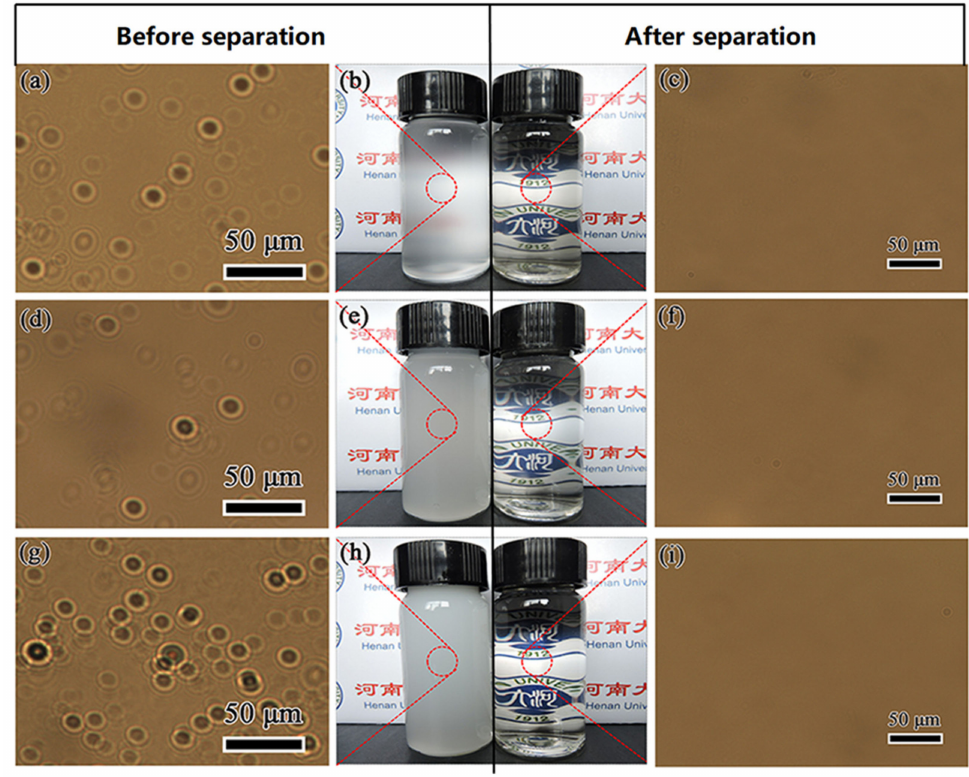
Figure 8. Optical microscopes and digital camera photos of different oil-in-water emulsions: ( a – c ) n-hexane/water, ( d – f ) n-dodecane/water and ( g – i ) n-hexadecane/water before and after separation.